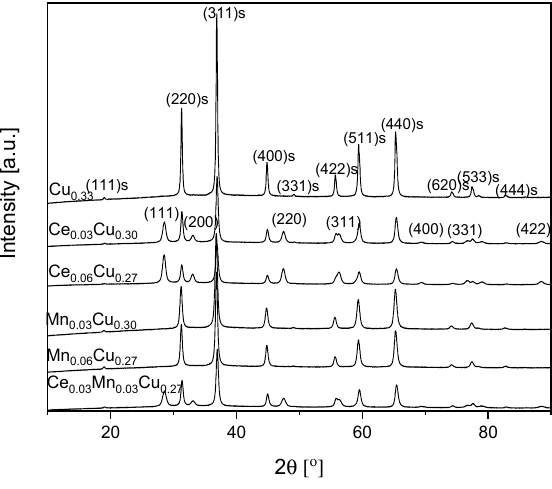
Figure 2. XRD patterns of Cu–Al catalysts doped with manganese and cerium. The reflexes coming from the pure spinel structure are marked by ‘s’. Table 1. Composition, crystallite sizes, and textural properties of Ce- and Mn-doped Cu–Al spinel catalysts.